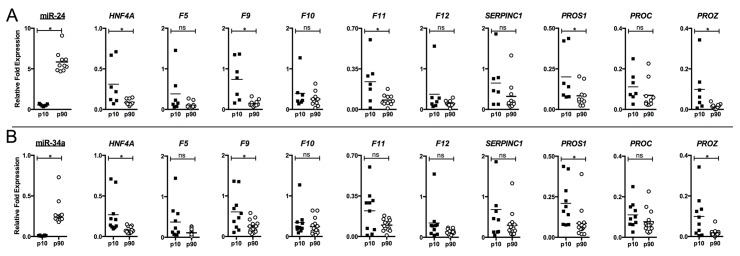
Expression range of miR-24 and miR-34a with HNF4A mRNA and its downstream targets in healthy livers.Dot plot diagram of HNF4A mRNA, selected coagulation factors and miR-24 (A) or miR-34a (B) levels in livers. P10 and p90 represent 10th and 90th percentiles of miR-24 (A) and miR-34a (B), respectively. Each data point represents an individual liver tissue sample. The results are presented as fold change with respect to the normalization standard. The asterisk indicates a statistically significant difference (P < 0.05) and “ns” indicates a statistically non-significant difference (P > 0.05).